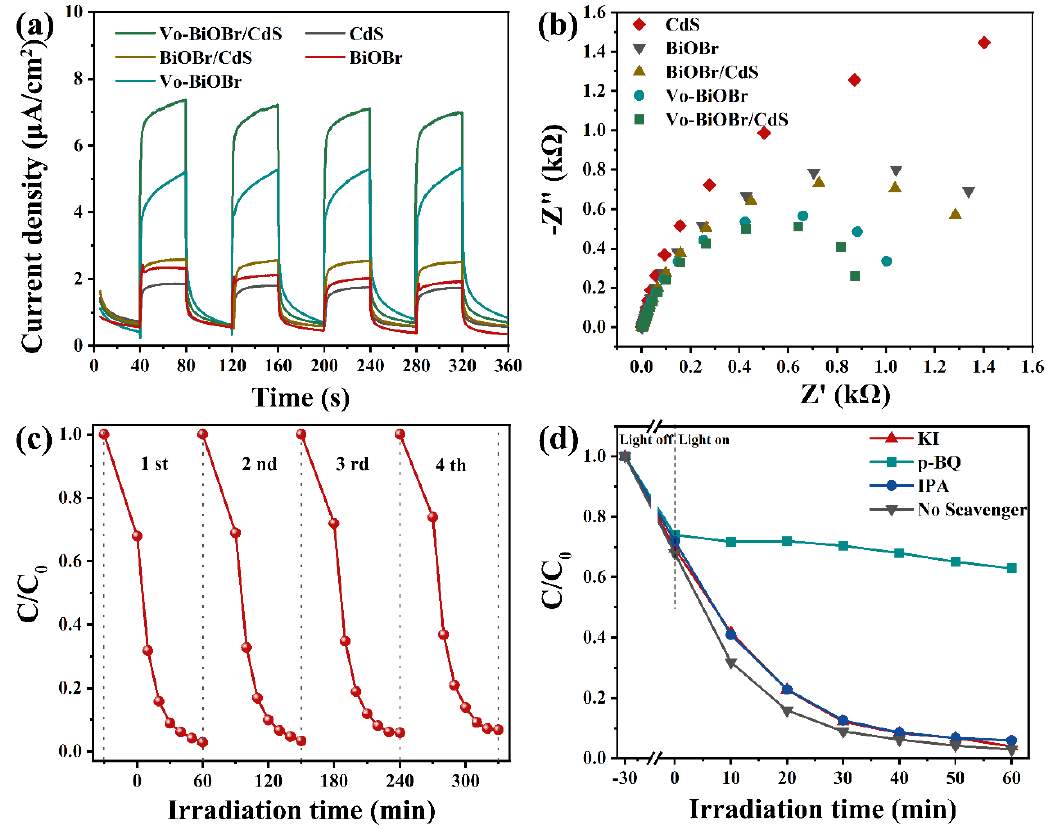
Figure 8. ( a ) Transient photocurrent responses; ( b ) EIS Nyquist plots of photocatalysts; ( c ) cycling test of photocatalytic degrading RhB over Vo-BiOBr/CdS; and ( d ) degradation activity of RhB containing different scavengers.